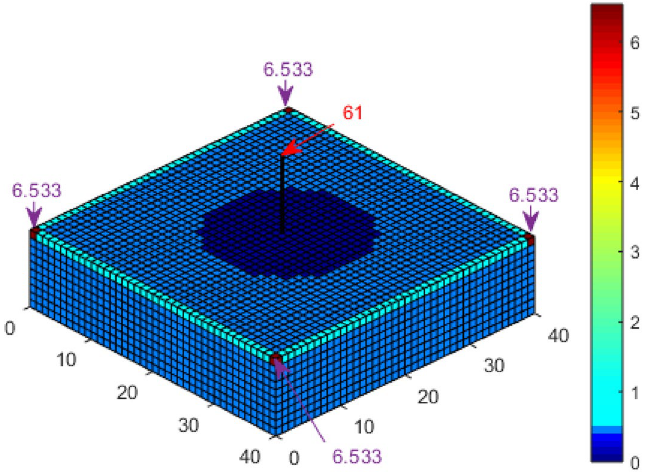
Figure 15. Lightning strike probability to a cuboid with central air termination using K P2C and confined space points.